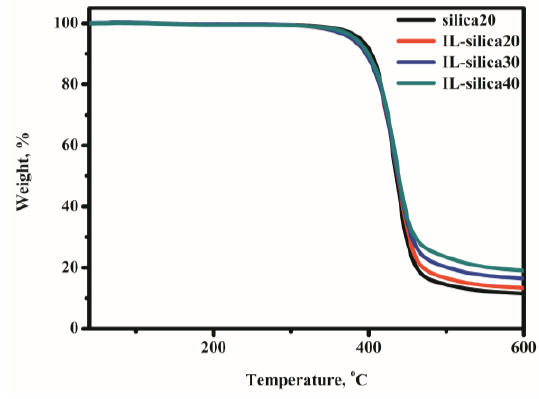
Figure 7. TGA thermograms of epoxy composites containing u-silica and IL-silica.